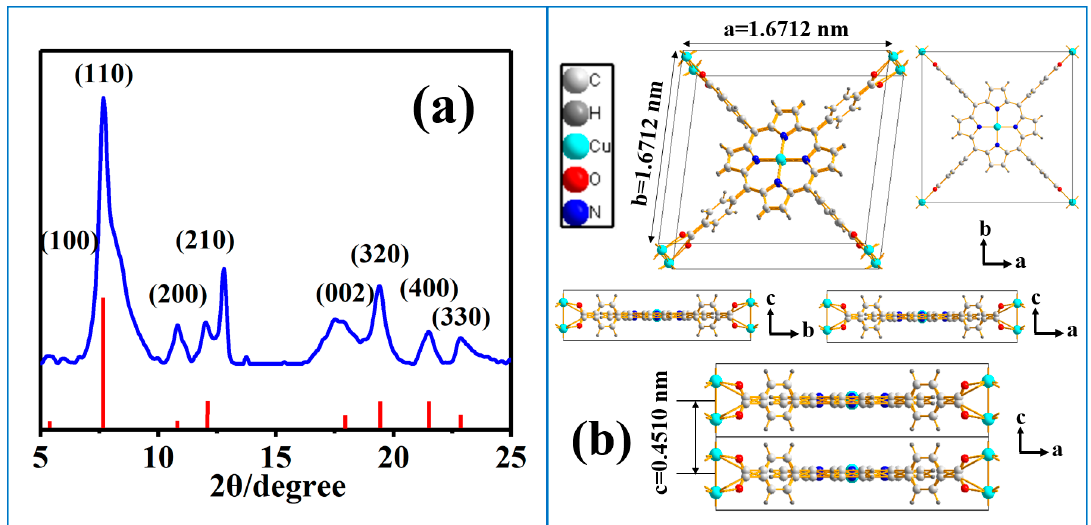
Figure 1. ( a ) XRD pattern of Cu-TCPP@MOFs, smoothed with Jade 6.0. ( b ) Projections of the proposed crystal structure of Cu-TCPP@MOFs on the ab plane, bc plane, and ac